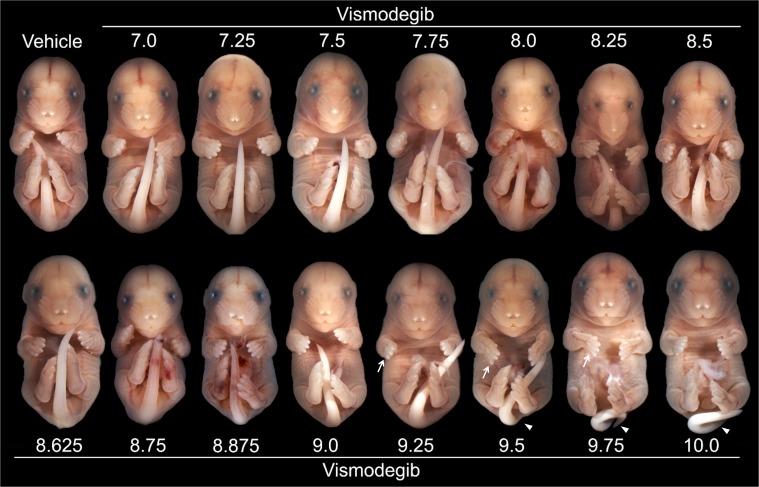
Additional stage of exposure-dependent phenotypes.Along with a vehicle-exposed control (A), representative examples of phenotypic outcomes are shown with numbers indicating the gestational stage of acute vismodegib administration. Later exposure was associated with forelimb ectrodactyly, as exhibited bilaterally in fetuses exposed from 9.25 to 9.75 (arrows point to absent fifth digits on the right limb). Kinked tail phenotypes were caused by exposure between GD9.5 and 10.0 (arrowheads). Edema is also apparent in fetuses exposed at GD9.75 and 10.0. For each treatment group the number of litters and fetuses examined, mean litter size and crown-rump length, and the incidence of edema, forelimb ectrodactyly, and kinked tail defects are presented in S1 Table.